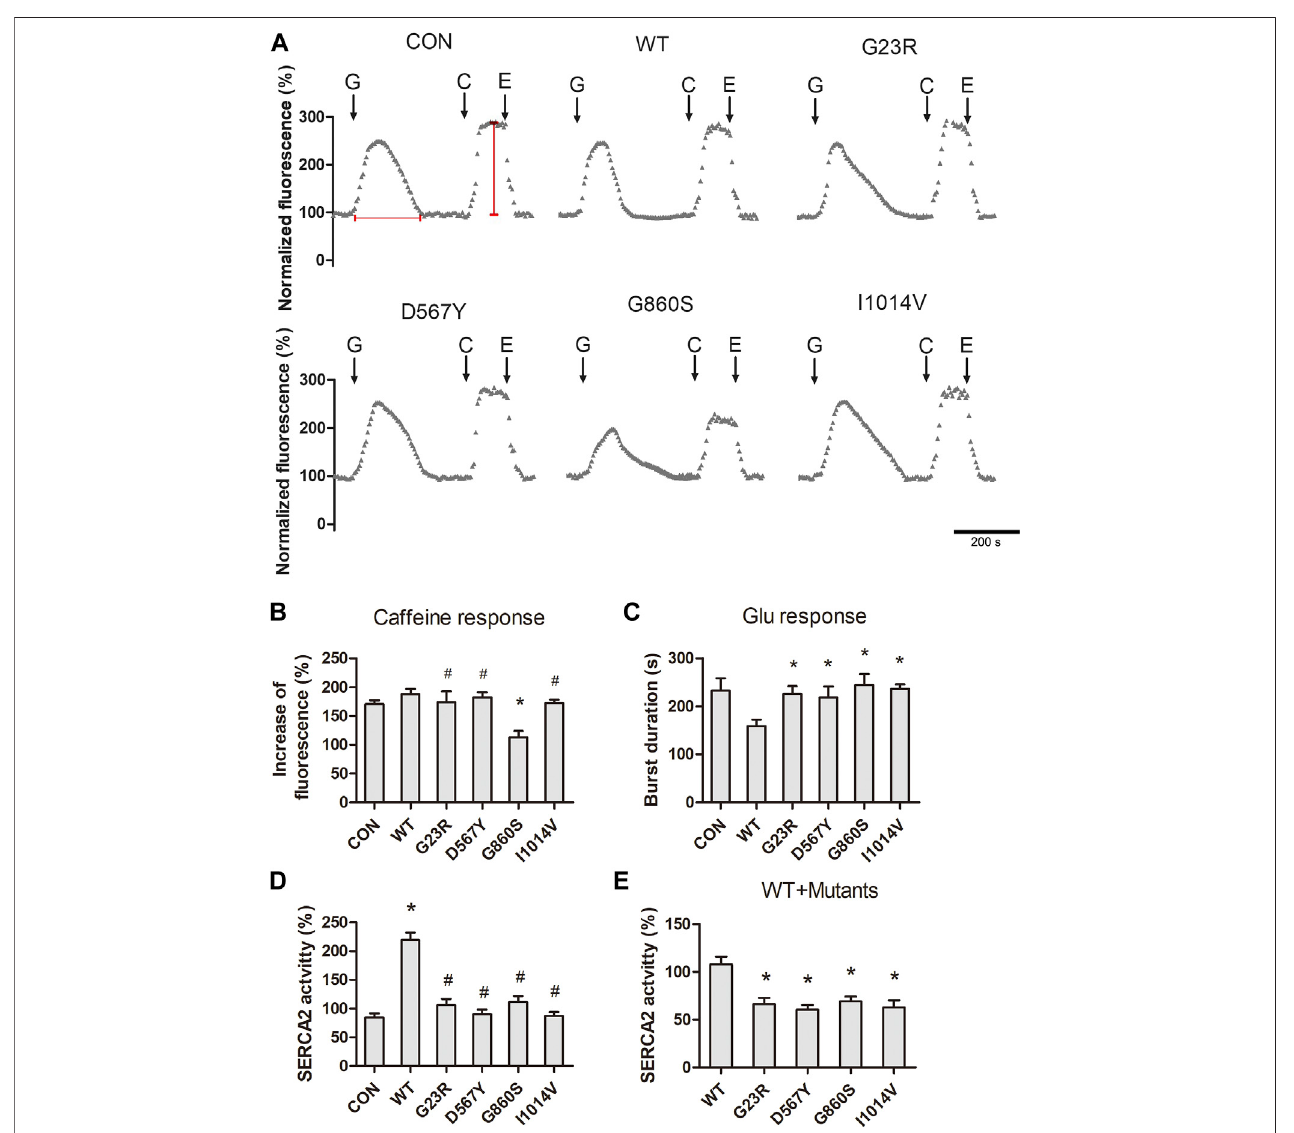
FIGURE 2 | Declined pump activity and cytoplasmic Ca 2+ clearance ef fi ciency in SERCA2 mutants. (A) Representative [Ca 2+ ] cyto response of SERCA2 mutants. The addition of glutamate (G), caffeine (C), EGTA (E) is indicated with black arrows. Scale bar, 200 s. Horizontal and vertical red lines represent the level of the [Ca 2+ ] cyto clearance ef fi ciency and [Ca 2+ ] ER storage, respectively. (B) Quanti fi cation of [Ca 2+ ] ER storage in response to caffeine. * p < 0.05 compared with WT group, # p > 0.05 compared with WT group, respectively. (C) Quanti fi cation of [Ca 2+ ] cyto clearance ef fi ciency in response to glutamate. * p < 0.05 compared with WT group, respectively. (D,E) : Quanti fi cation of SERCA2 activity of mutants when transfected alone (D) or co-transfected (E) , SERCA2 mutants were inactive and even inhibited endogenous SERCA2 activity. (D) : * p < 0.05 compared with CON group, # p > 0.05 compared with CON groups respectively. (E) : * p < 0.05 compared with WT group.